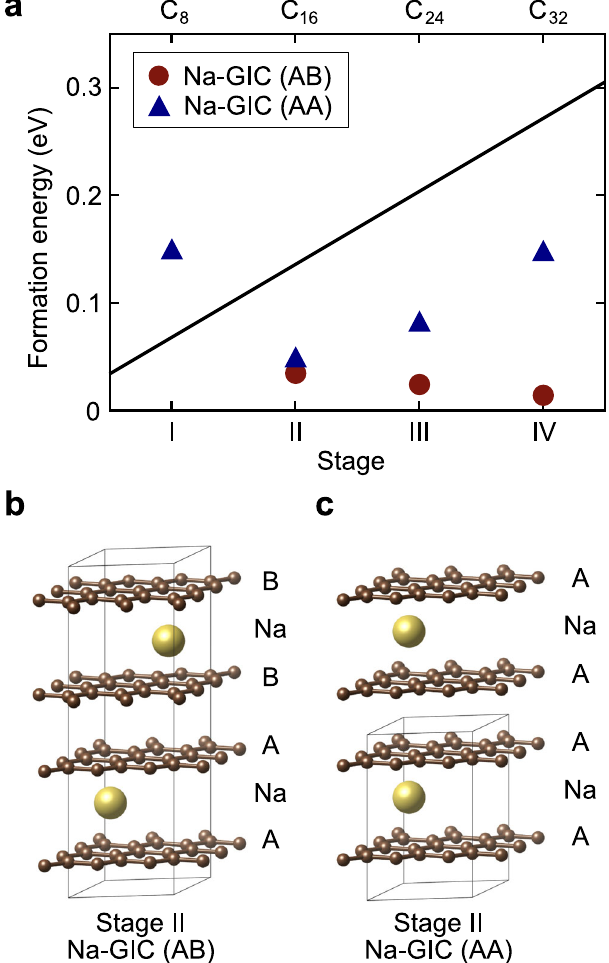
Fig. 2 Formation energy and structures of Na-GICs. a The formation energy of Na-GICs with respect to AB-stacking graphite and BCC Na metal. The dashed line indicates the formation energy of AA-stacking graphite. Schematic structures of stage II Na-GIC with b AB-stacking and c